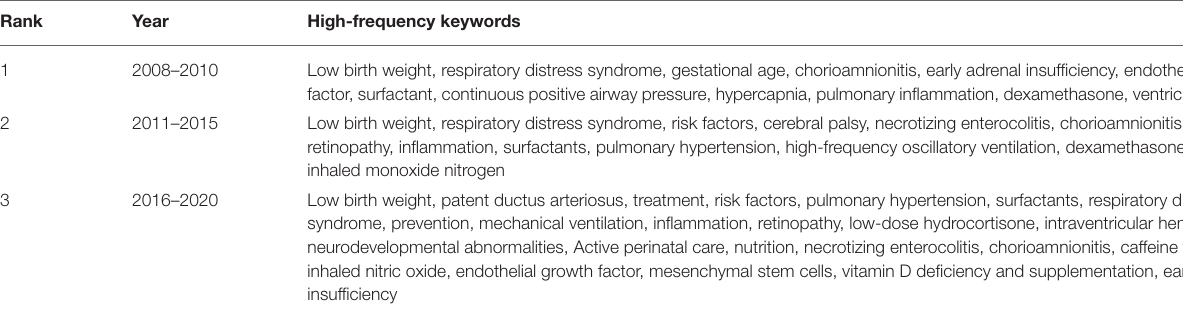
TABLE 5 | High-frequency keywords of BPD in extremely pre-mature infants.